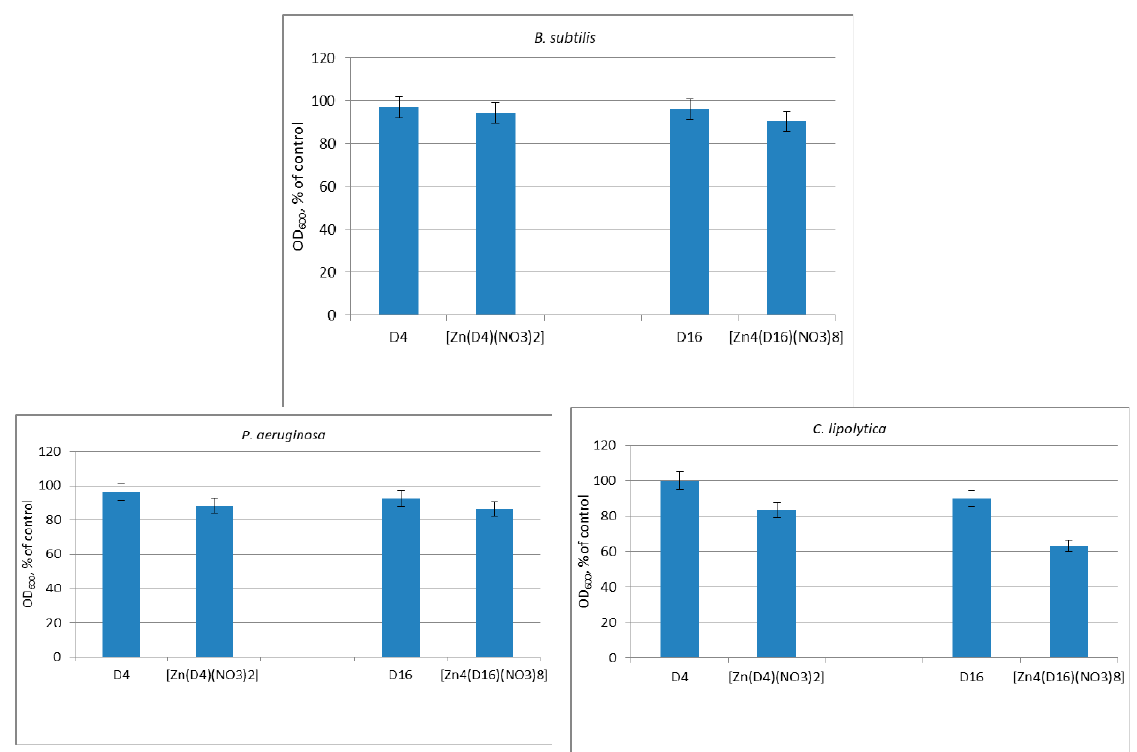
Figure 4. The effect of untreated cotton fabric D4 and D16 (controls) and cotton fabrics treated with Zn(D4)(NO 3 ) 2 and Zn 4 (D16)(NO 3 ) 8 on the growth of the test microbial strains.